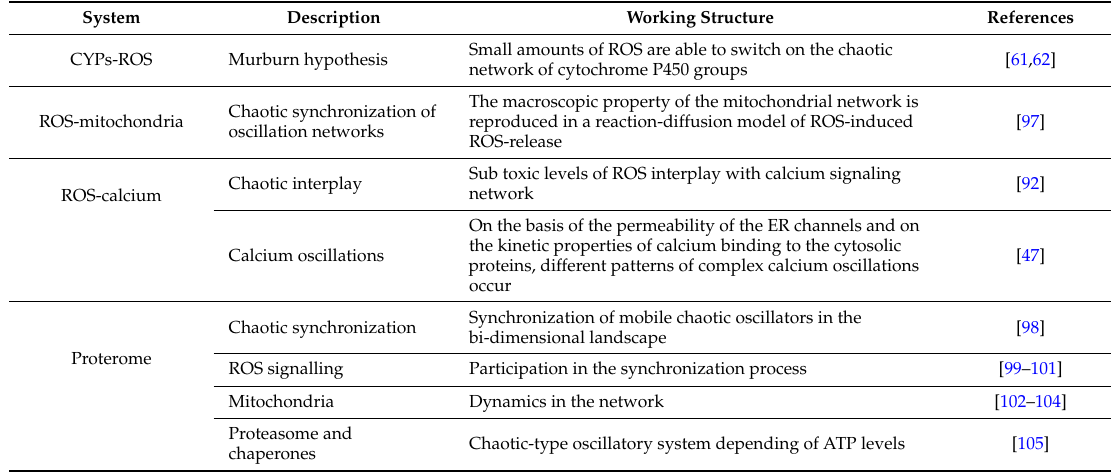
Table 1. Chaotic behaviour of some signalling pathways and macromolecular systems in the activity of